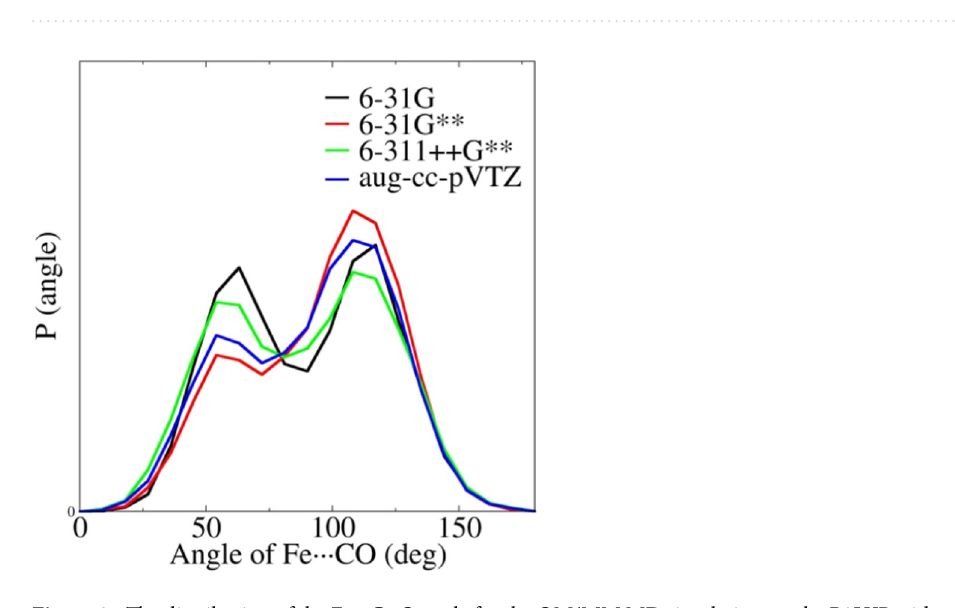
the contour plot that the distributions of the C and O atoms were both concentrated. The predicted locations of the B state in the 2 ns QM/MM MD simulation were at the edge of the distal heme pocket adjacent to the porphy- rin ring c , which is in good agreement with the X-ray experiment. Meanwhile, the CO molecule lay approximately parallel to the heme plane in the 2 ns QM/MM MD simulation, which is also in good agreement with the X-ray experiment. More detailed analysis indicated that the distribution of the center of mass of the CO for both the B 1 and the B 2 states was concentrated in the same location, with the CO molecule displaying an antiparallel orienta- tion. The C and O atoms of the CO alternately formed a weak hydrogen bond with the H atom of the − NH group of the His64 during the MD simulations, which provided an anchoring force for trapping the CO. In fact, the CO molecule remained in the docking site following 4 ns QM/MM MD simulations. Therefore, 2 ns MD simulations will not make the CO molecule move out of the docking site. The B3LYP is one of the most widely used density functionals 44 and is expected to provide an accurate calcu- lation of the electrostatic potentials for protein. The QM/MM MD simulation was thus first performed using the B3LYP method. To test the effects of the size of the basis sets, a series of up to 2 ns QM/MM MD simulations with a QM subsystem treated via B3LYP/6–31 G, B3LYP/6–31 G ** , B3LYP/6–311 ++ G ** , and B3LYP/aug-cc-pVTZ were carried out, with the results shown in Fig. 3. It can be seen from the figure that the size of the basis sets in the QM/MM MD simulations had an obvious effect on the simulated results. The predicted ratio of the B 1